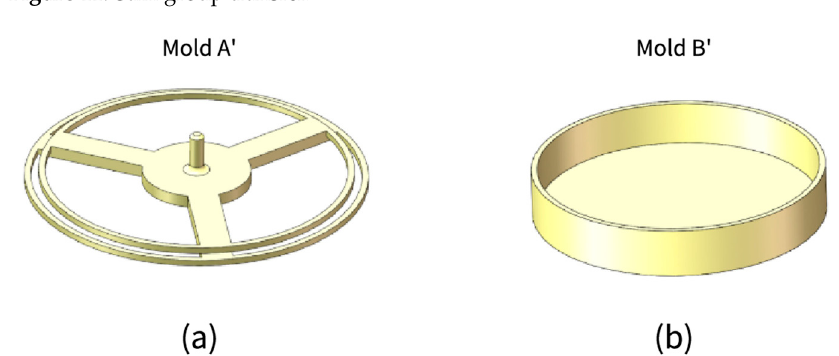
Figure 11. Sam group transfer.